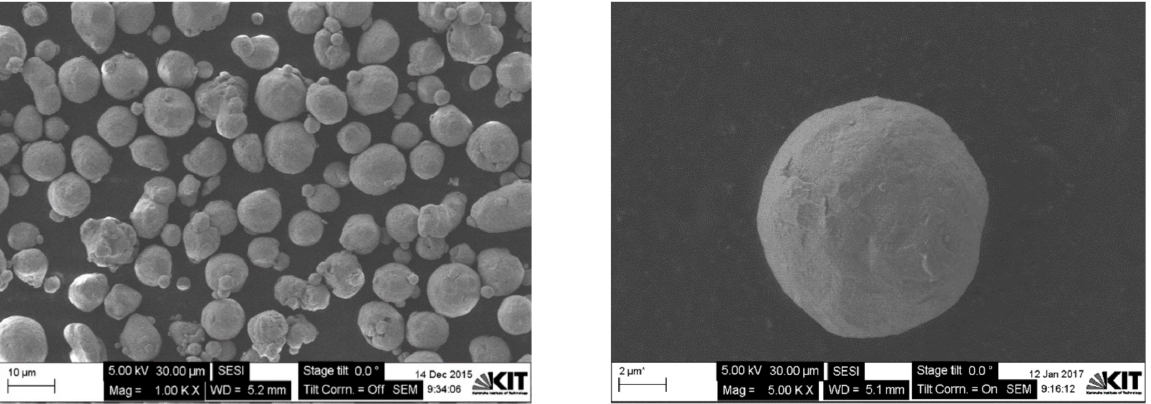
Figure 9. Cu particles with 10 µ m APS.